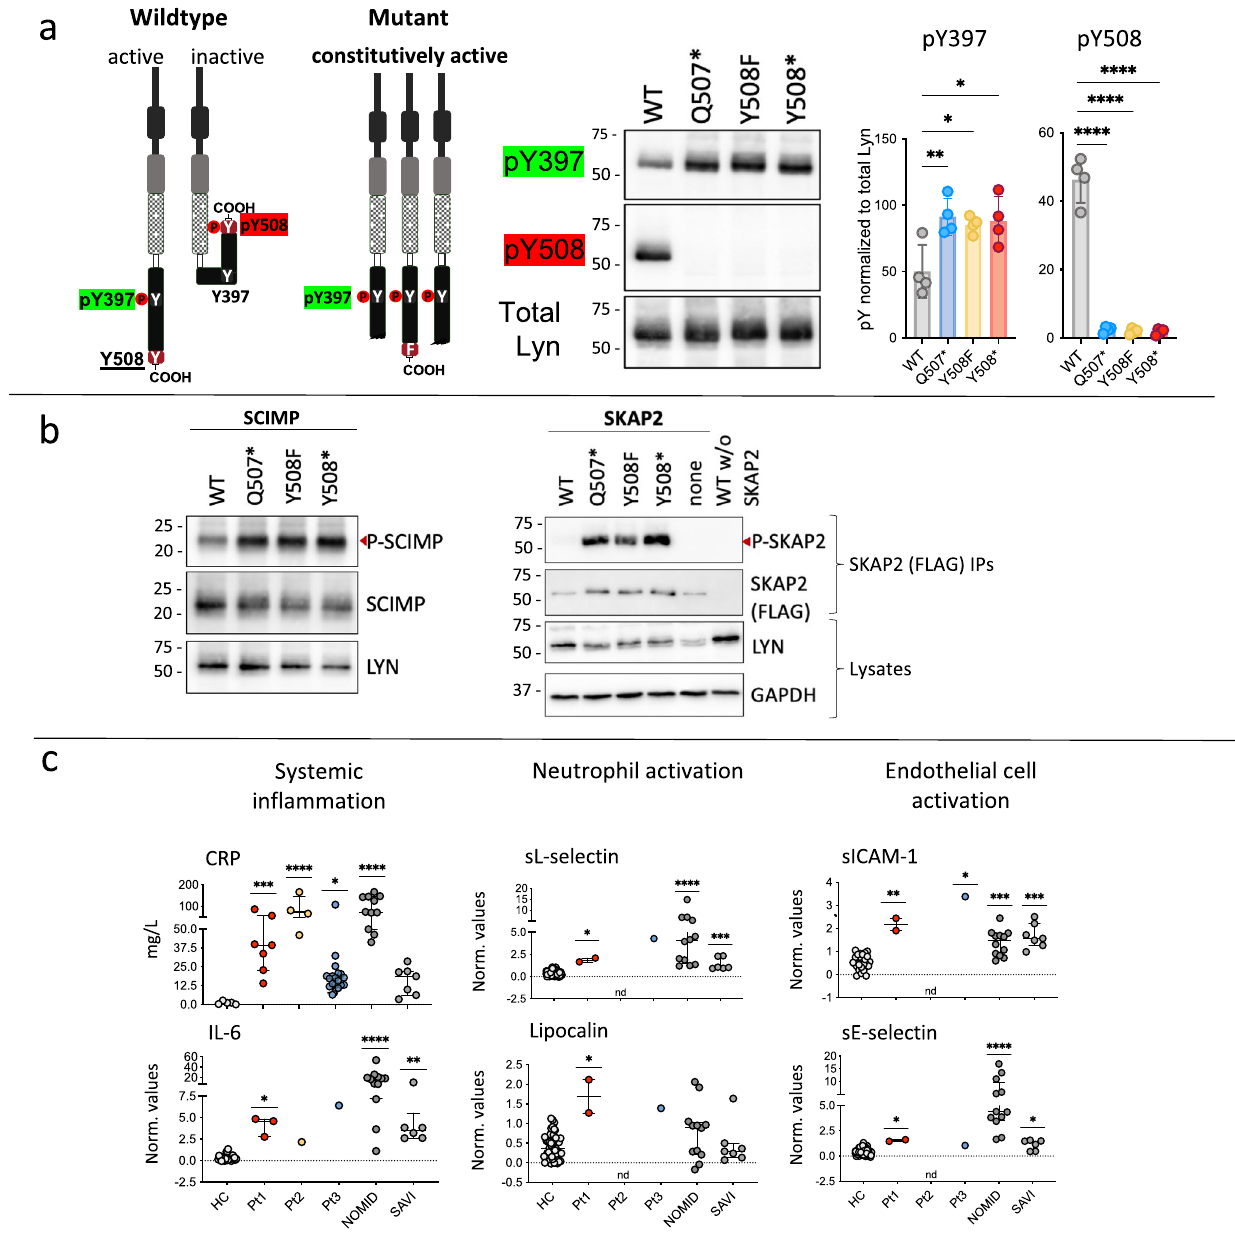
Fig. 3 | Constitutive Lyn kinase activation and evidence of systemic in fl am- mation and endothelial activation. a Phosphorylation-dependent active and inactive con fi guration of Lyn kinase. Disease-causing LYN variants lead to con- stitutiveactivation(leftpanel).Westernblotoflysatesfromtransientlytransfected HEK293FT(wild-type(WT)ormutant LYN) demonstrateincreasedphosphorylation of p.Y397 and absent phosphorylation of p.Y508 in the mutant constructs (center panel).Data of 4 biologically independent experiments isgraphed in a scatter plot with bar graphs depicting mean values ± SD. p.Y397 comparisons, WT versus: p.Q507*, p =0.0082, p.Y508F, p =0.0228; or p.Y508*, p =0.0137. p.Y508 compar- isons, WT versus: p.Q507*, p <0.0001, p.Y508F, p <0.0001 or p.Y508*, p <0.0001. * p <0.05,** p <0.01,**** p <0.0001asdeterminedbyordinaryone-wayANOVAwith Bonferroni ’ s multiple comparison post-test. b Phosphorylation of Lyn adaptor proteins,Scimp(leftpanel),andSkap2(rightpanel)intransiently LYN constructco- transfected HEK293FT cells. Red arrow heads indicate phosphorylated Lyn kinase substrates. Depicted are representative images of n=3 independent experiments forScimpandSkap2. c Pre-treatmentsamplesfromthe3patients(Pts.1-3)andfrom patientswith the systemicautoin fl ammatory diseases, neonatal-onset multisystem